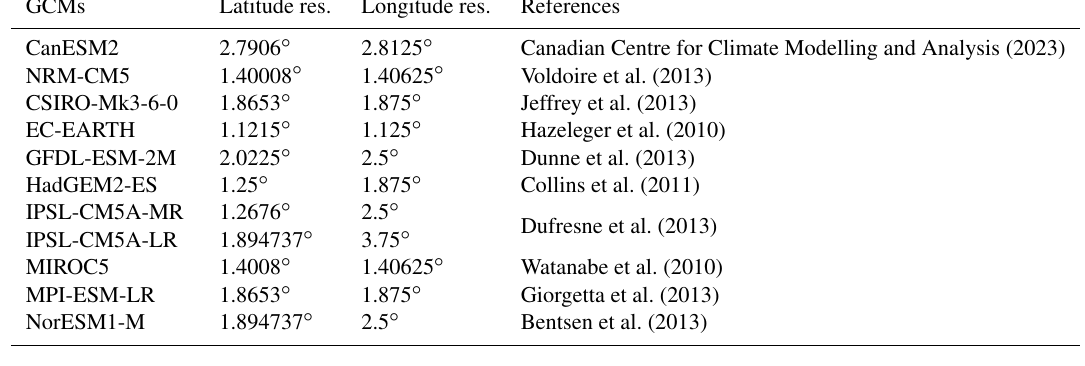
Table 3. Horizontal resolution of the CMIP5 GCMs used as driving fields in the CORDEX-Africa simulations. GCMs Latitude res. Longitude res.